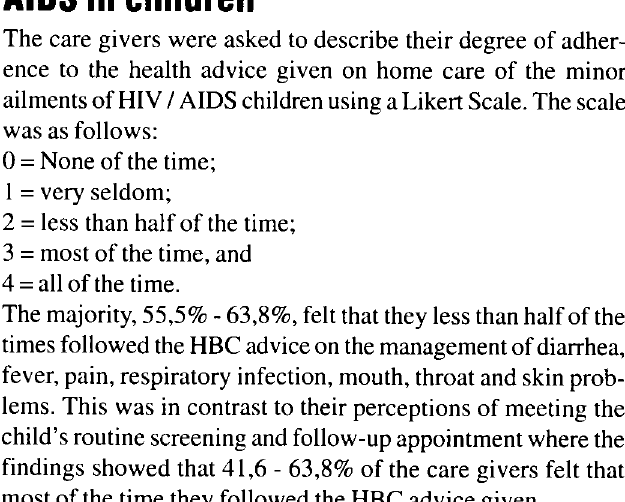
Table 3: The period of registration with the